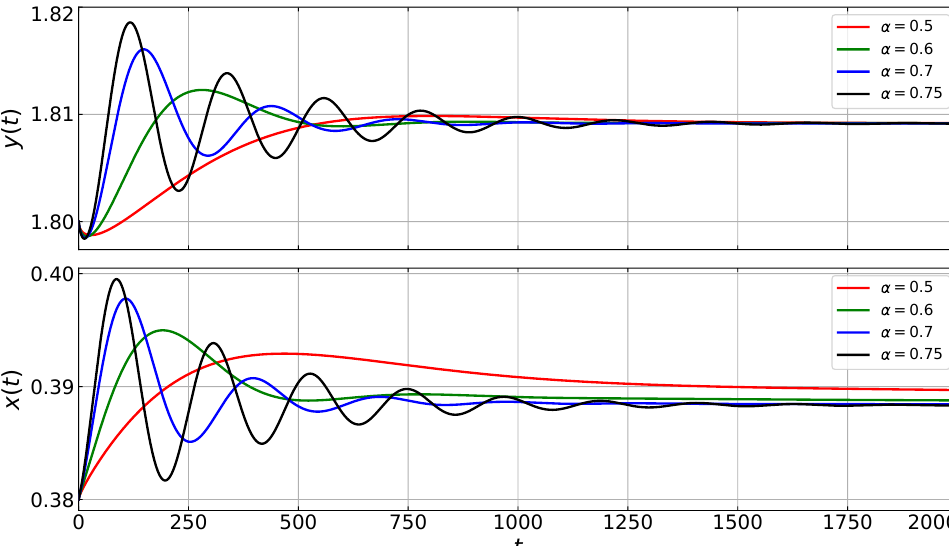
Figure 5. Time series of system (6) with parameter values (29) and the initial conditions taken around the interior point ˆ S = ( 0.38825,1.80915 )